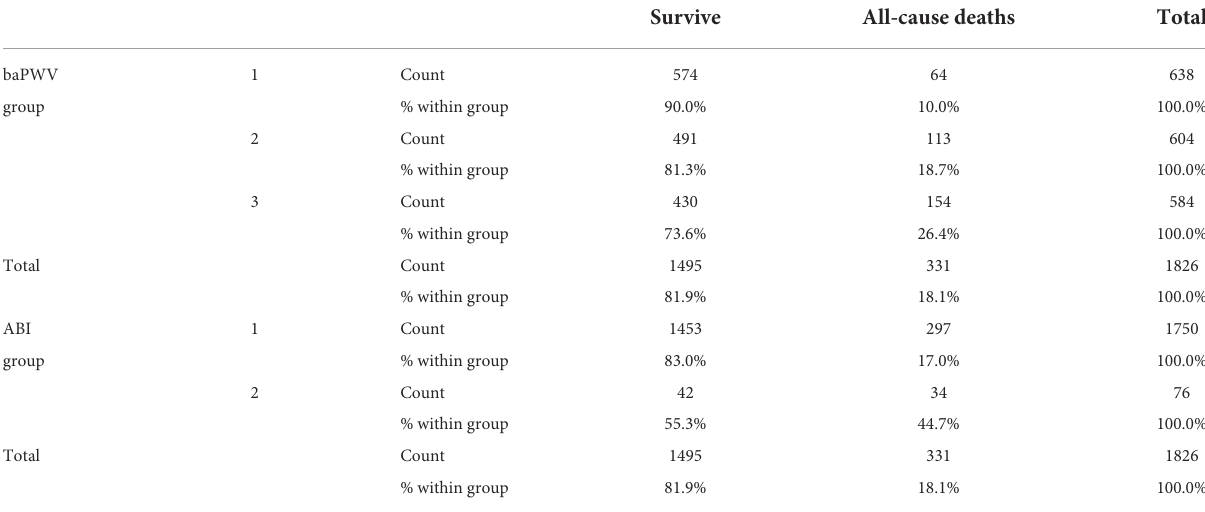
TABLE 2 All-cause mortality in different